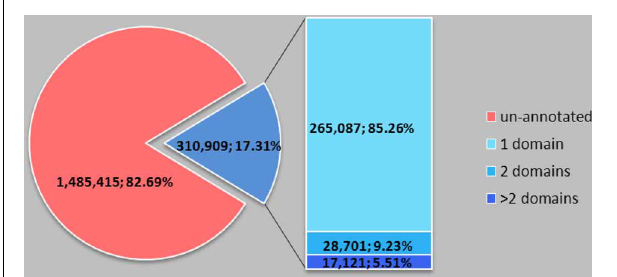
FIGURE 1 | Domain number distribution of small proteins in NCBI genpept. SP usually contains a single domain. The NCBI genpept database contains 14,324,397 proteins, including 1,796,324 (12.54%) SPs. Only 310,909 (17.31%) SPs, about 2.17% of total proteins, are annotated,